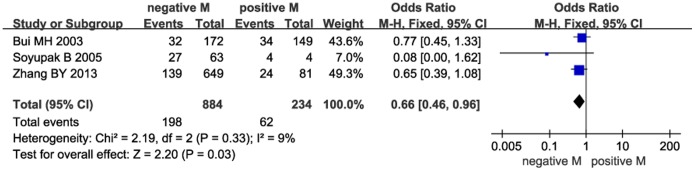
Meta-analysis of the association between low CAIX expression and distant metastasis.